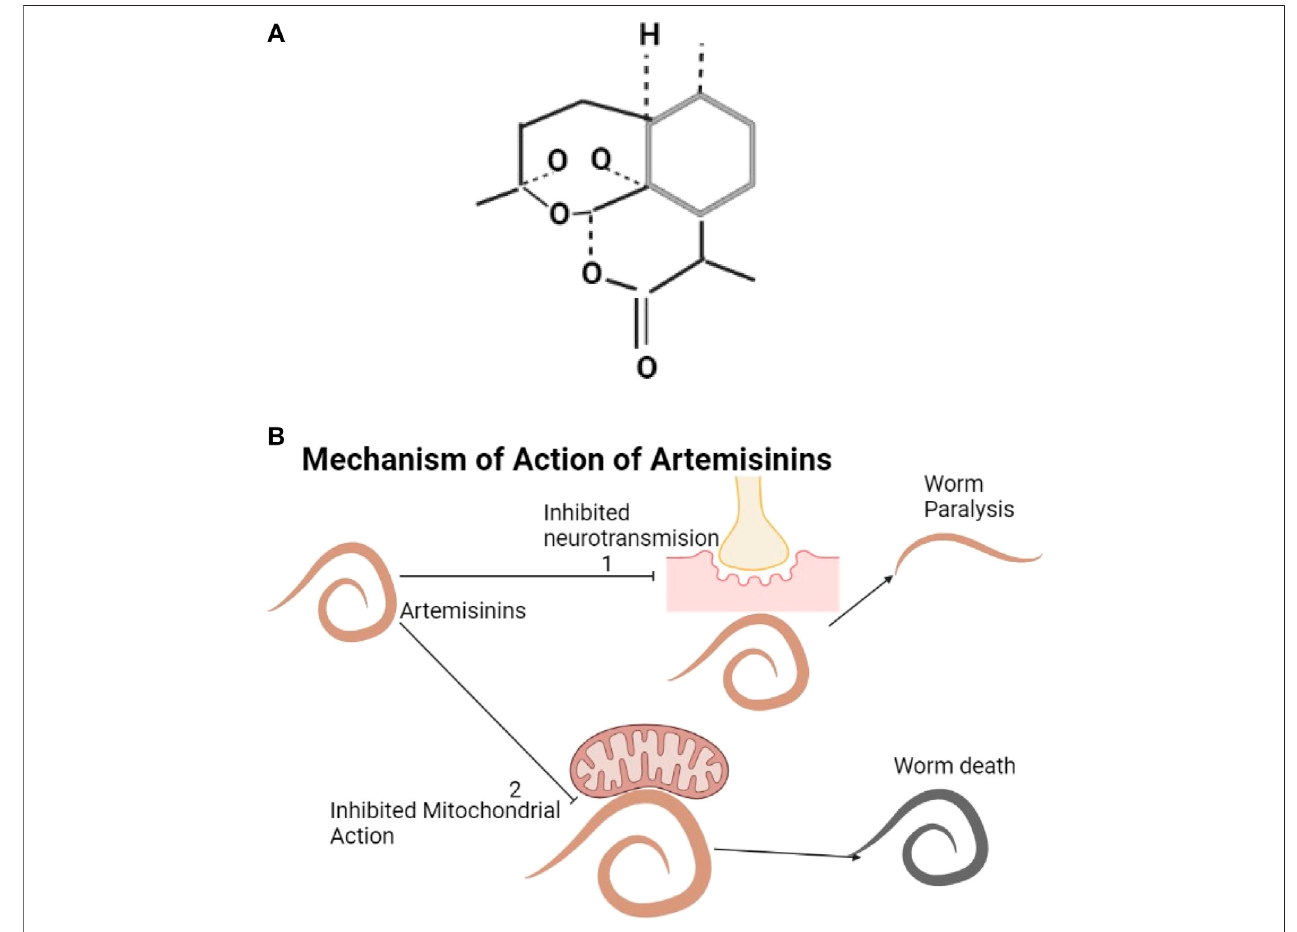
FIGURE 7 | (A) The structure of artemisinin (Zeyuan, Yulin, and Meiyi, 2018). (B) Artemisinin and its derivatives inhibit neurotransmission resulting into worm paralysis (1) and can affect mitochondrial action resulting into worm death (2).